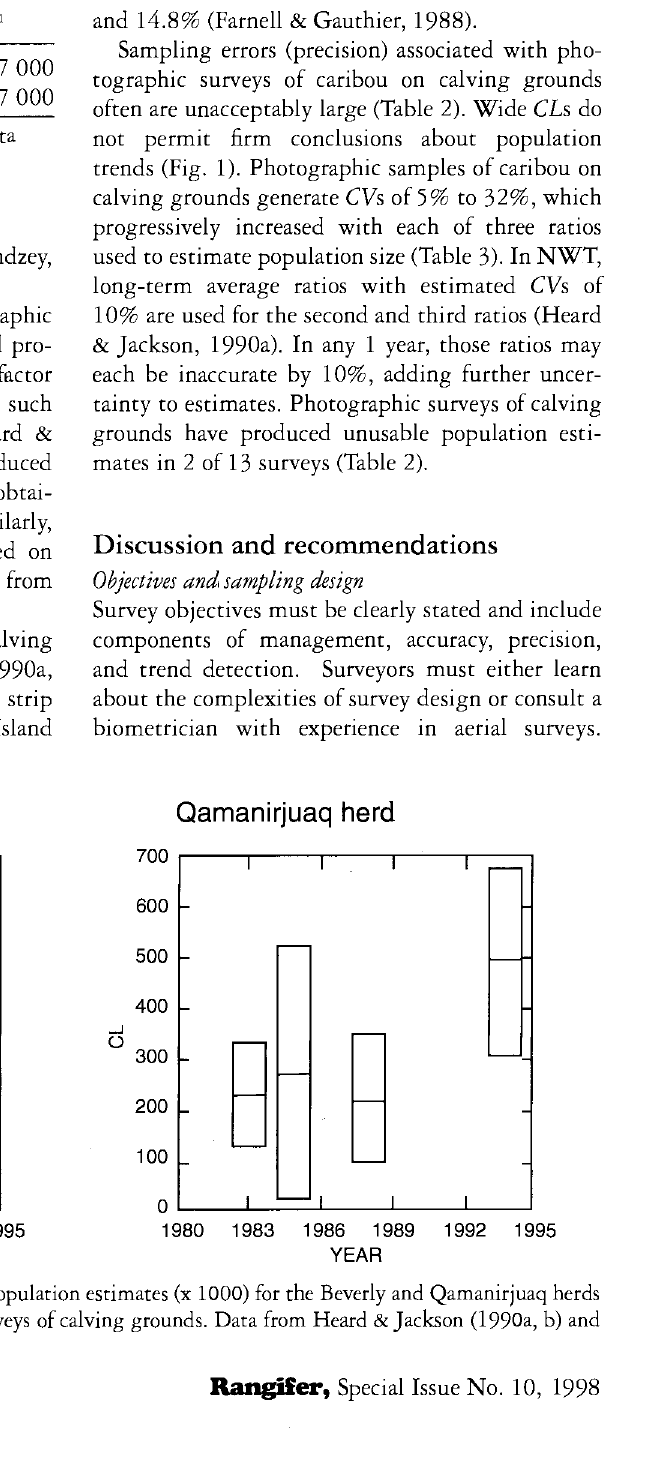
Table 1. An example, selected because of unusually low coefficients of variation (CV), of results of visual strip and photographic surveys of caribou on the calving grounds of the Qamanirjuaq herd in